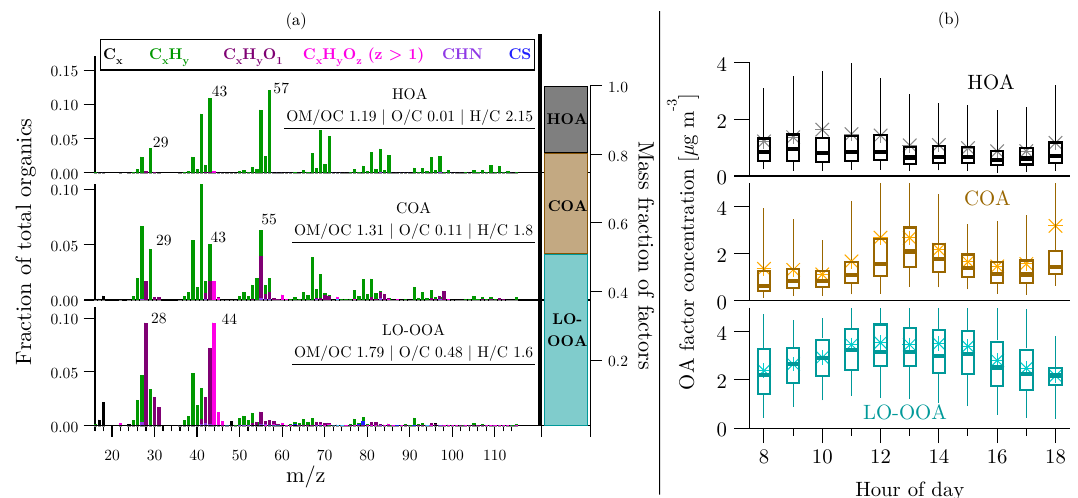
Figure 4. (a) Mass spectra, elemental ratios, and average mass fraction of factors obtained from PMF analysis of all AMS spectra. (b) Box plot of diurnal profiles of factors: rectangles enclose the first through third quartiles of data. Horizontal bars are medians. Asterisk markers are means. Whiskers are the 5th and 95th